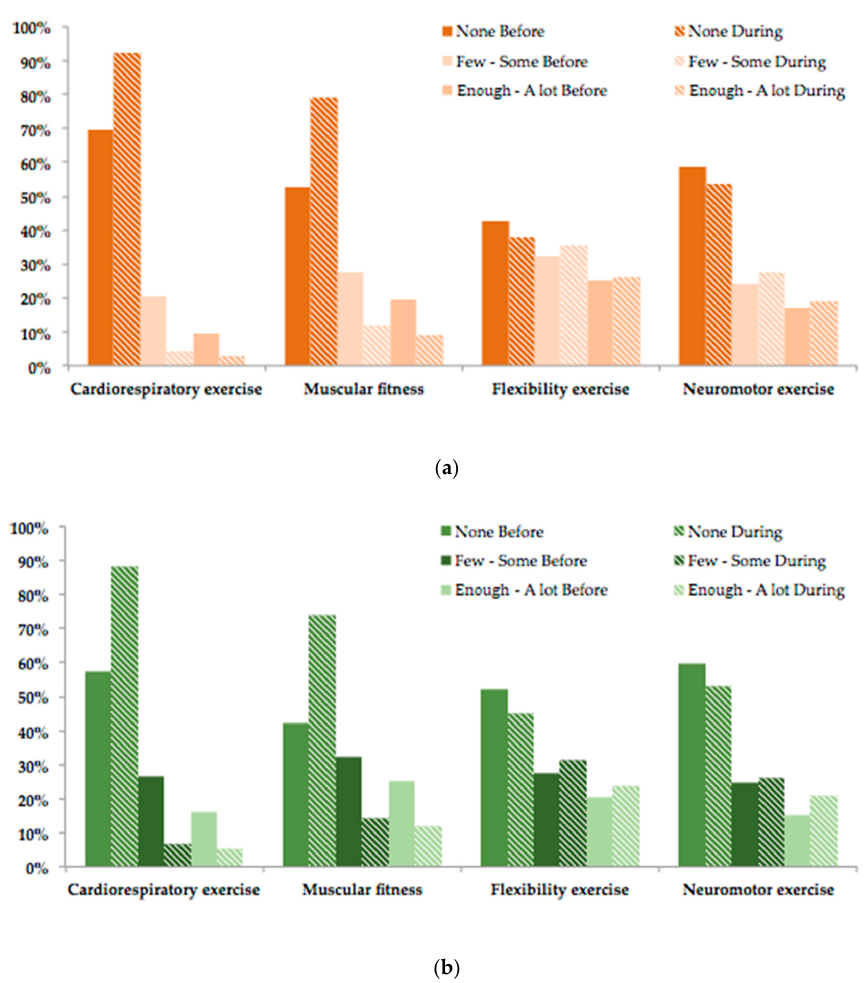
Figure 1. Comparison of the type of PA practiced before and during the confinement, based on [33], in women ( a ) and men ( b ).